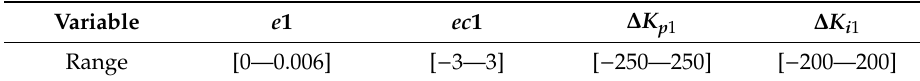
Table 2. Ranges of the input and out variables for H 2 .